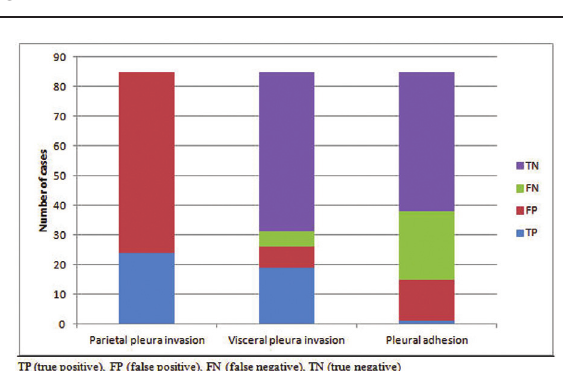
Table 3 Relation between thoracoscopic findings and pleural fluid cytology Thoracoscopic findings